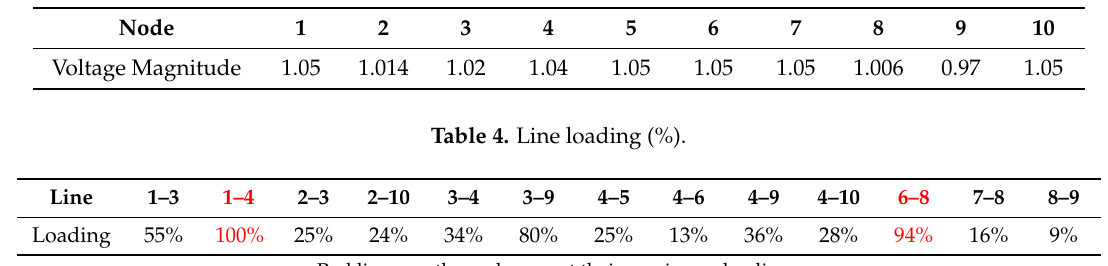
Table 3. Nodal voltage magnitude (p.u.).